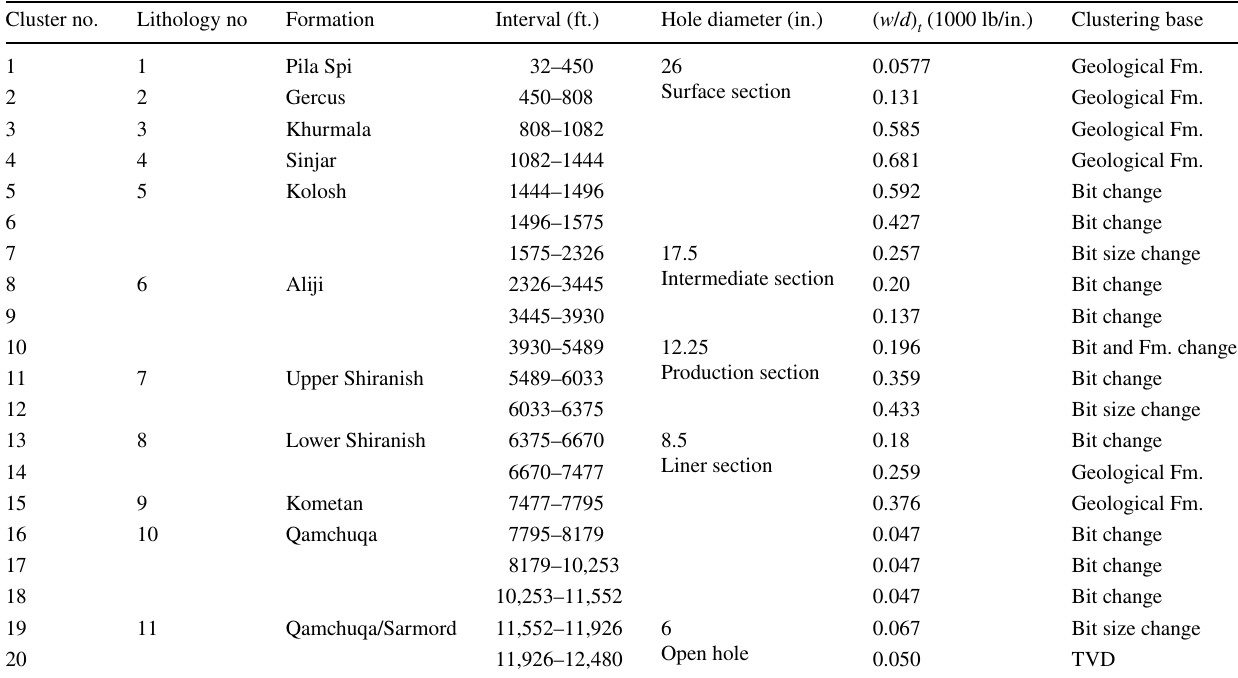
Table 1 Bn-1 clustering intervals and threshold weight Cluster